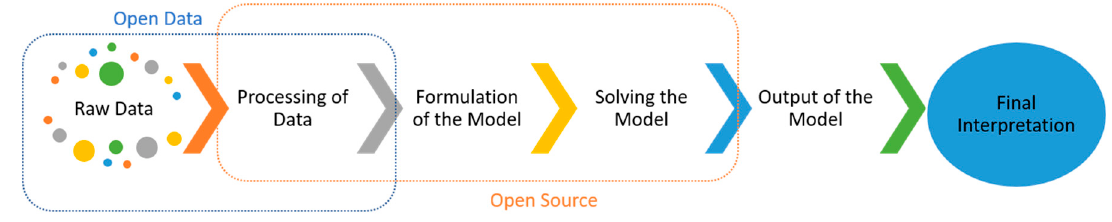
Figure 6. The process of energy modelling according to Openmod Philosophy. Adapted from [101,102].